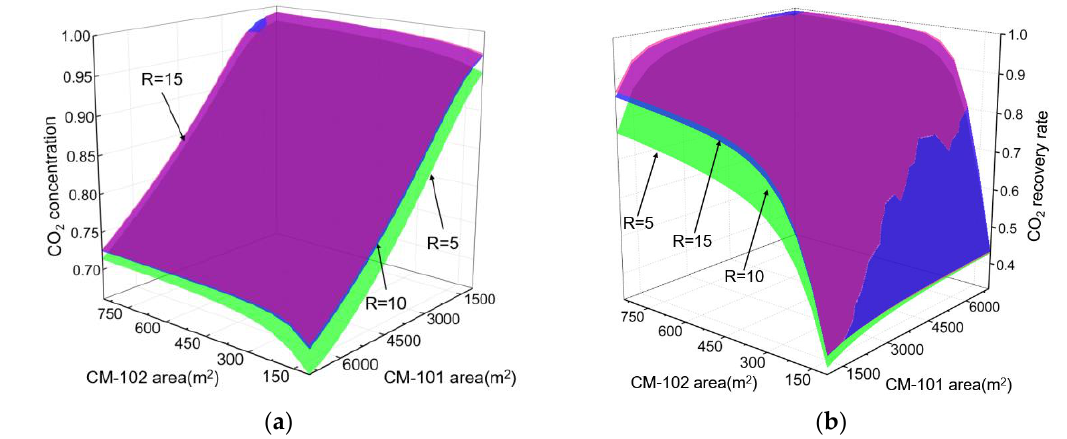
Figure 6. Effect of CM-101 and CM-102 area on CO 2 concentration and recovery rate under different Figure 6. E ff ect of CM-101 and CM-102 area on CO 2 concentration and recovery rate under di ff erent pressure ratios. ( a ) Effect of CO 2 -selective membrane area on CO 2 molar concentration; ( b ) effect of pressure ratios. ( a ) E ff ect of CO 2 -selective membrane area on CO 2 molar concentration; ( b ) e ff ect of CO 2 -selective membrane area on CO 2 recovery rate. CO 2 -selective membrane area on CO 2 recovery rate.